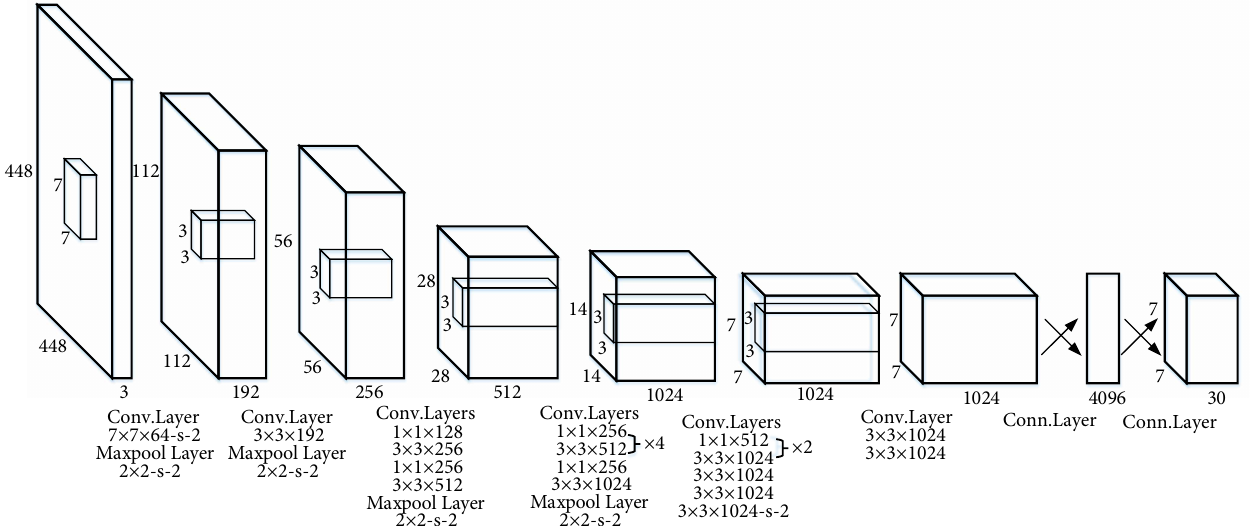
Figure 7: CNN architecture for object identification